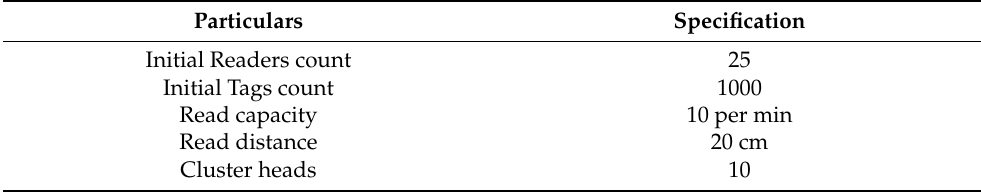
Table 1. Primary data